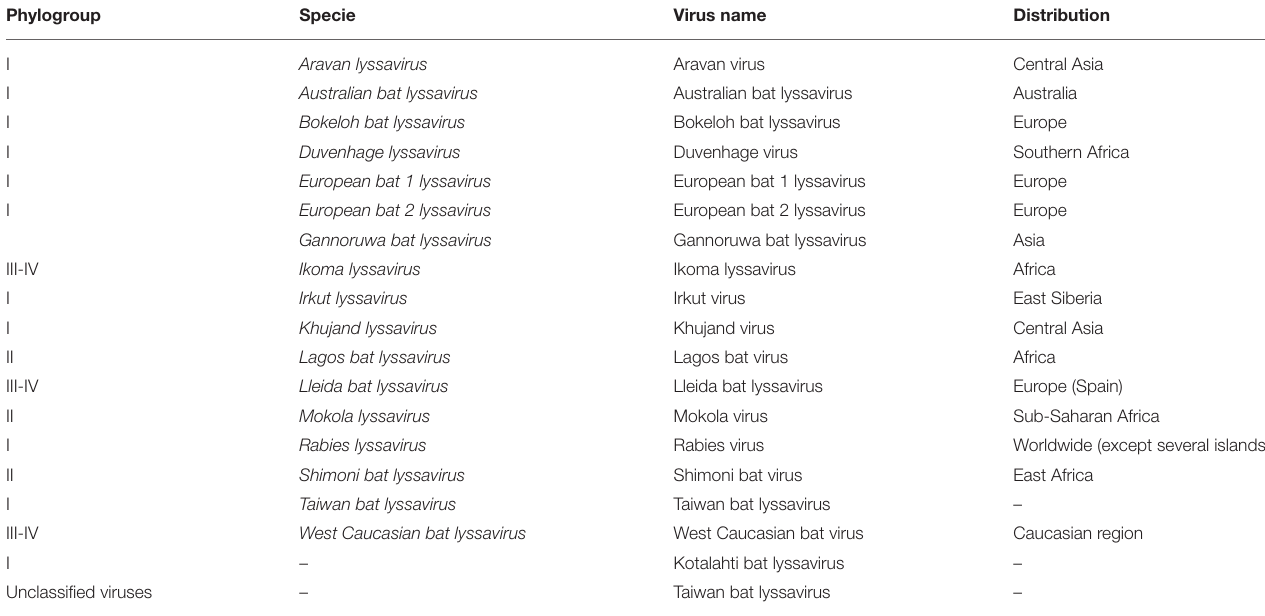
TABLE 1 | Classification of the species of the genus Lyssavirus and geographical distribution.